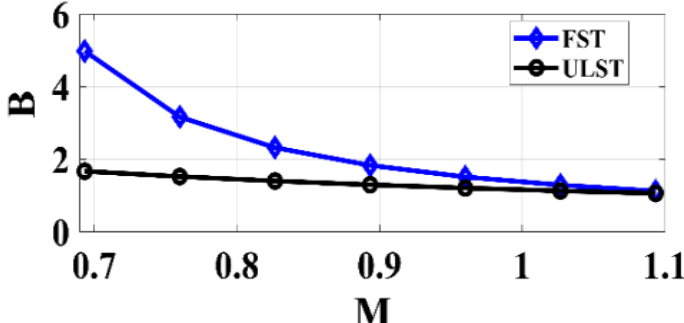
Figure 2. Graph of ‘B’ and ‘M’ for ULST and FST schemes using a single impedance network.